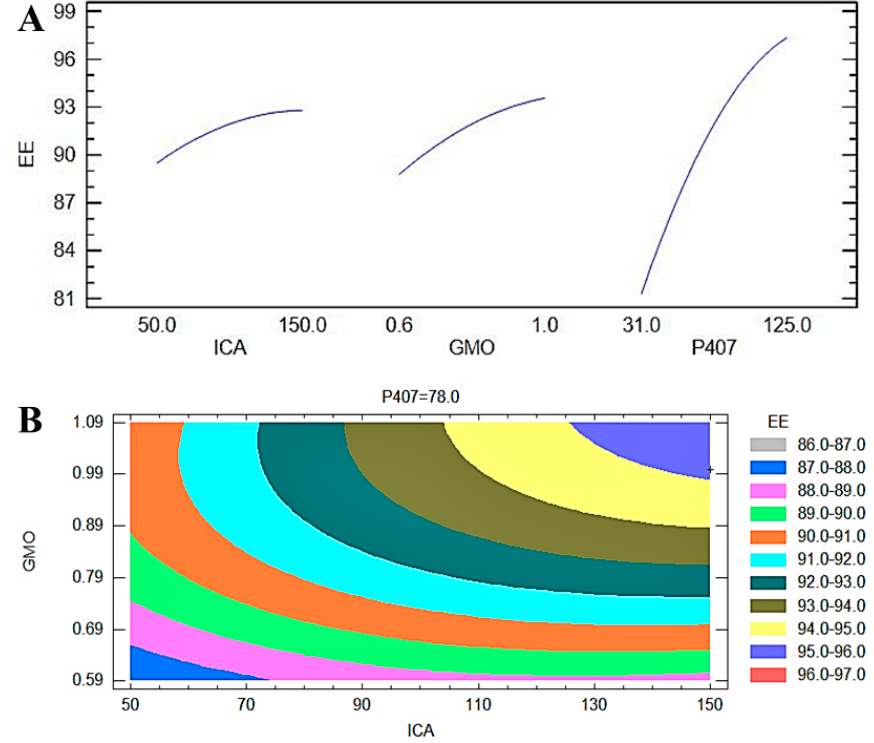
Figure 5. ( A ) Main plot effect of the ICA, GMO, and P407 concentrations on the EE of the ICA-Cubs formulation. ( B ) Contour plot of the effect of the ICA, GMO, and P407 concentrations on the EE of the ICA-Cubs formulation.